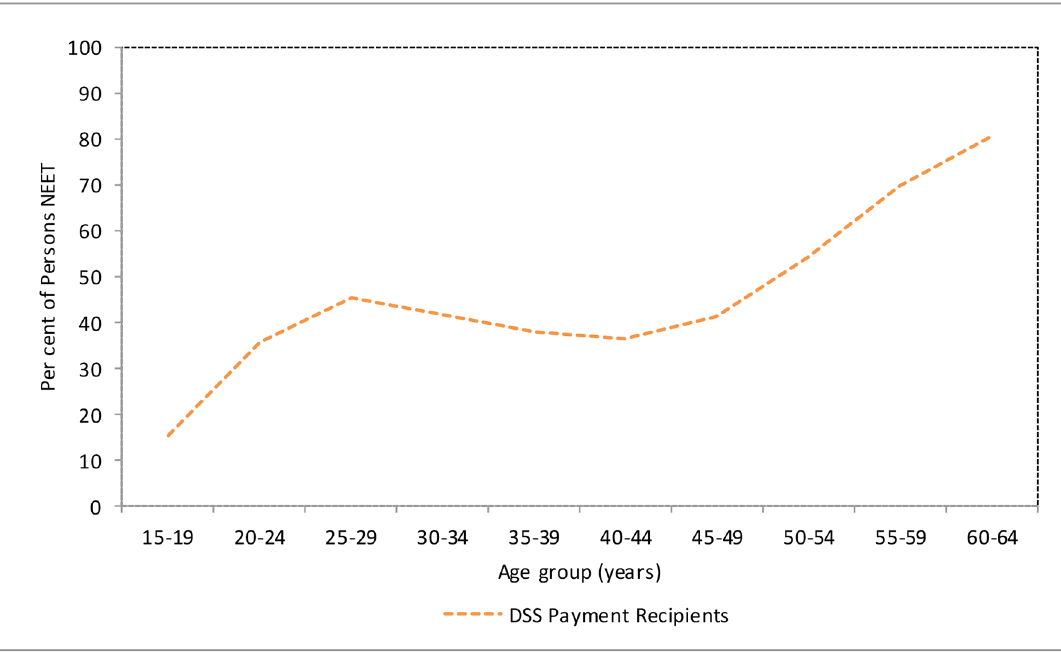
Figure 1: NEETs in Australia – proportion of linked DSS payment recipients aged 15–64 years classified as NEET, by age